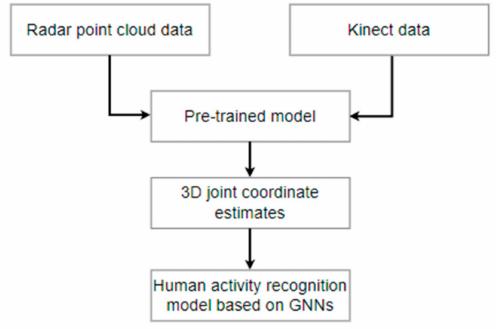
Figure 8. Schematic representation of the proposed